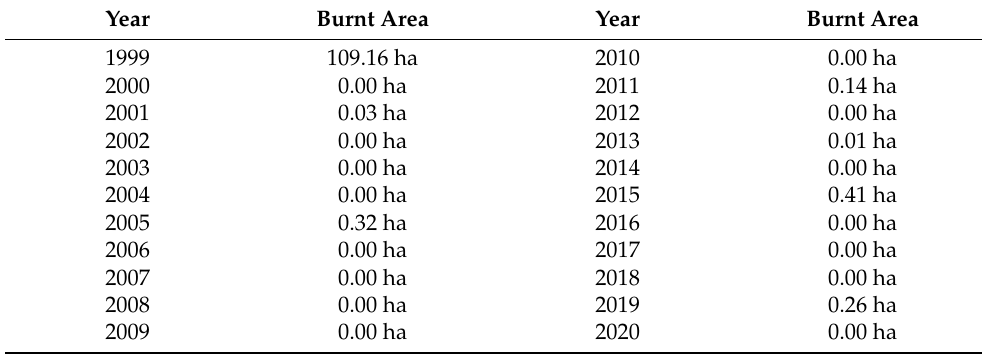
Table 1. Forest fires in the studied